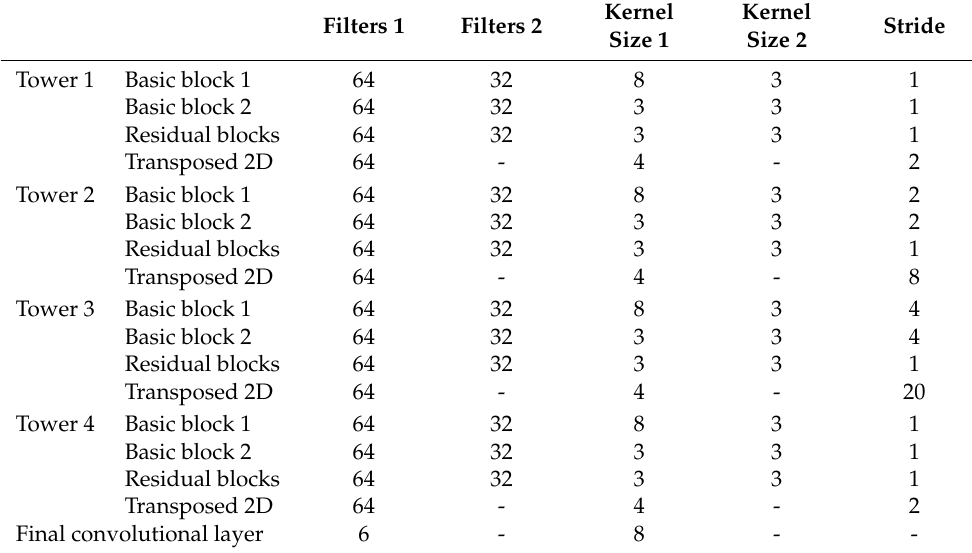
Table 2. All network parameters for the tower networks in the second part of the